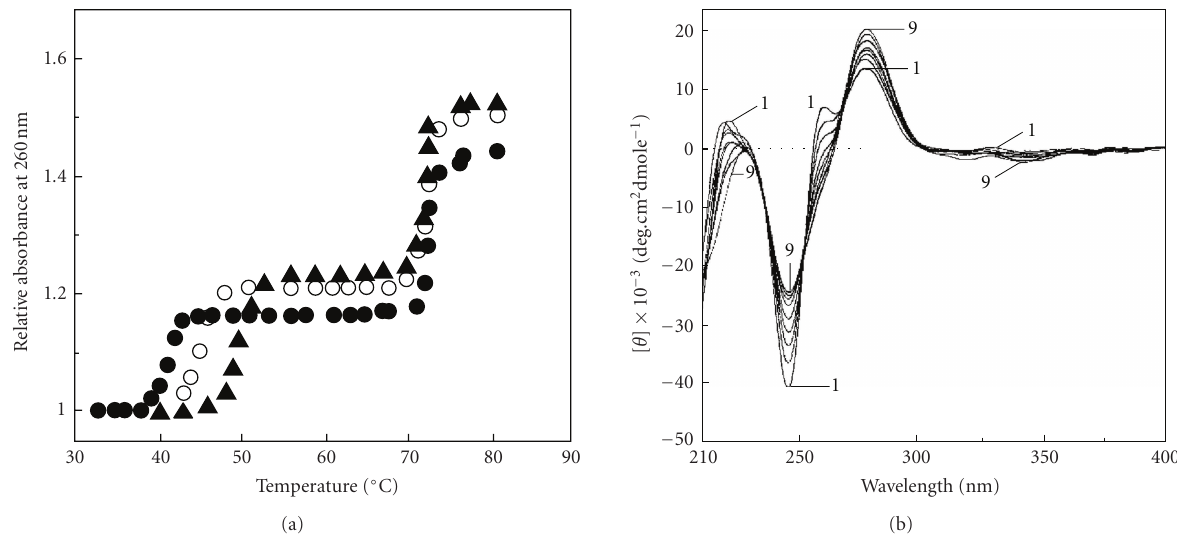
Figure 3: (a) The thermal melting profile of poly(dT) · poly(dA)xpoly(dT) triplex (- • -) and its complex with berberine at alkaloid/DNA ratio of 0.1 (-O-) and 0.3 (- (cid:2) -). (b) Circular dichroic spectrum (1) of the same triplex (48.8 μ M) with increasing concentrations up to (31.05 μ M) of berberine (9). Reprinted in part from Das et al. [48] with permission from 2003 Adenine Press. Table 2: Comparative binding parameters of interaction of various alkaloids with calf thymus DNA and covalently closed superhelical DNA.